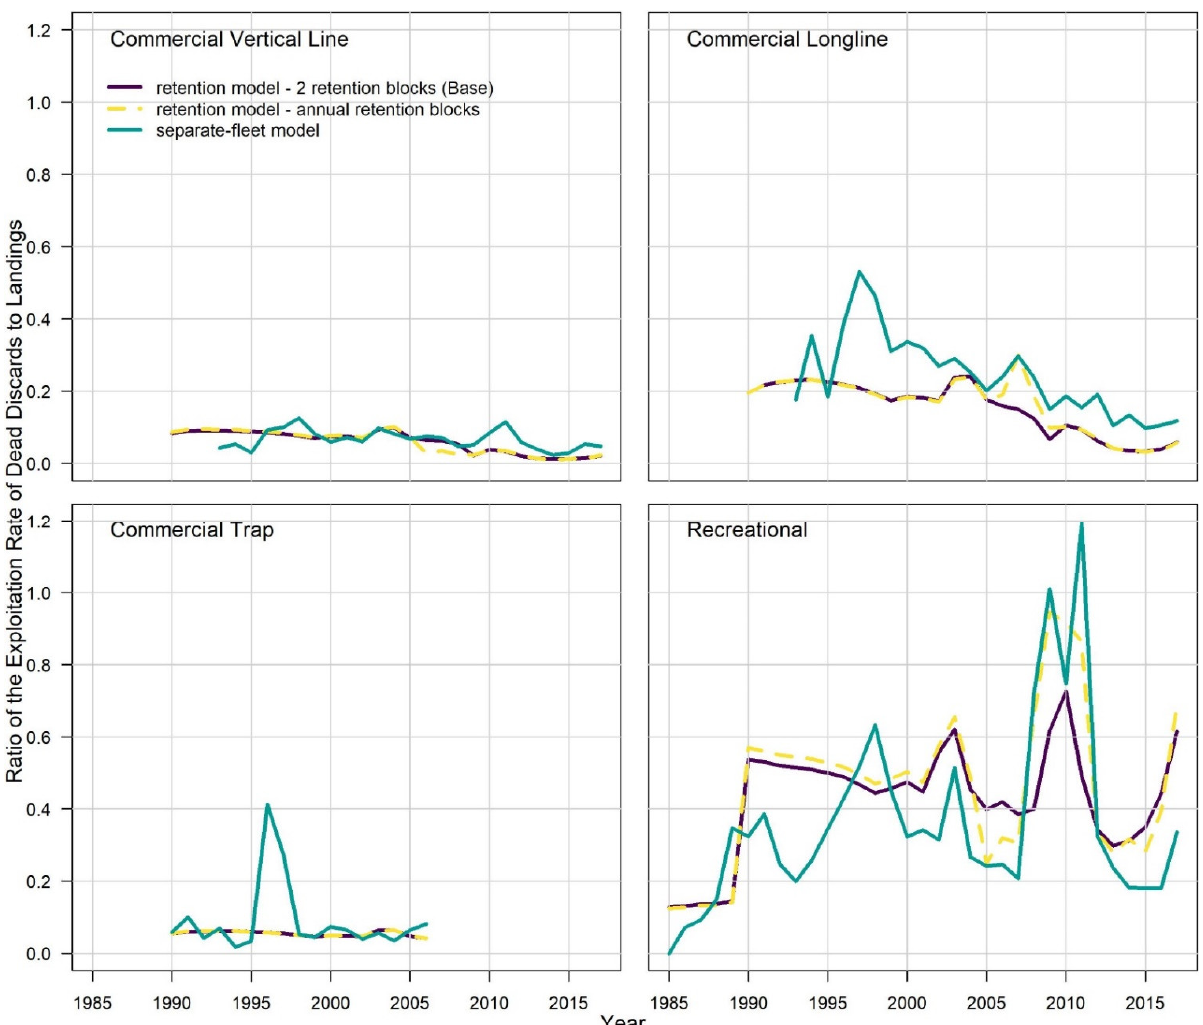
Figure 7. Comparison of exploitation rates from dead discards (total biomass discarded dead/total biomass) to exploitation rates from landings (total biomass landed/total biomass) for each fishery as estimated for each Gulf red grouper model implementing different approaches to including discards.